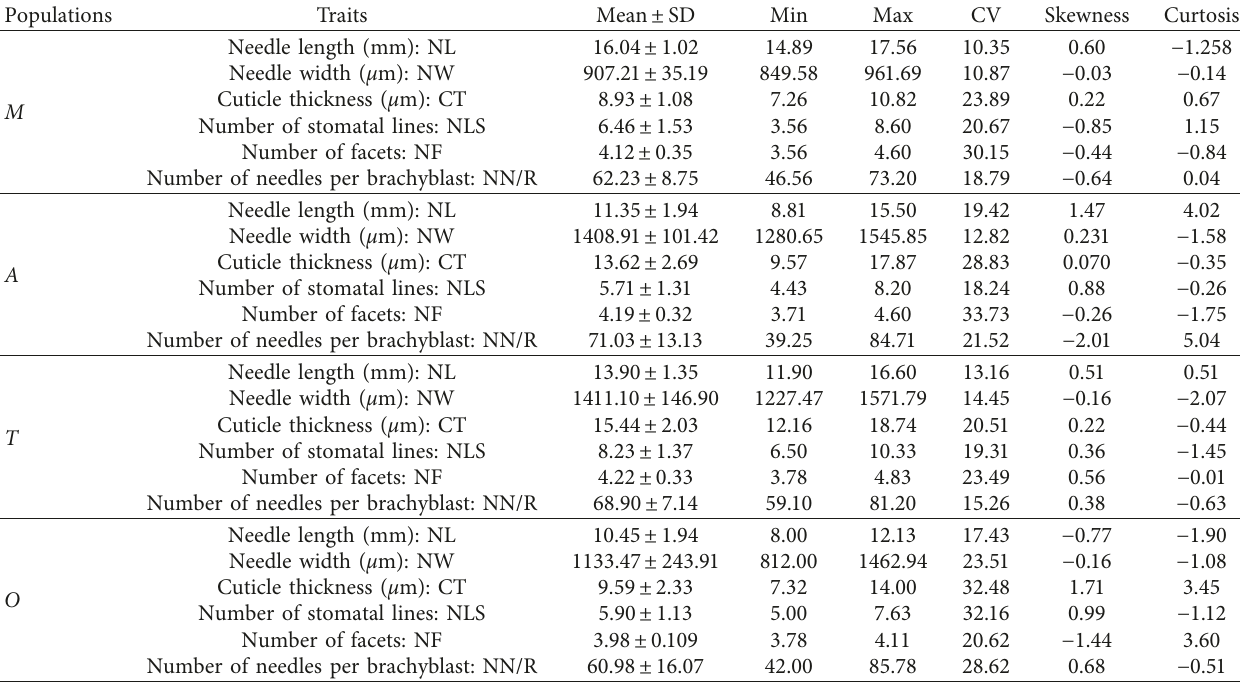
Table 2: Descriptive statistics of six quantitative traits of the studied populations of C. atlantica in Morocco. Populations Traits